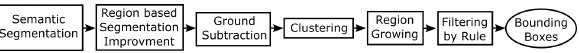
Figure 2. Overview of the workflow for bounding box extraction.